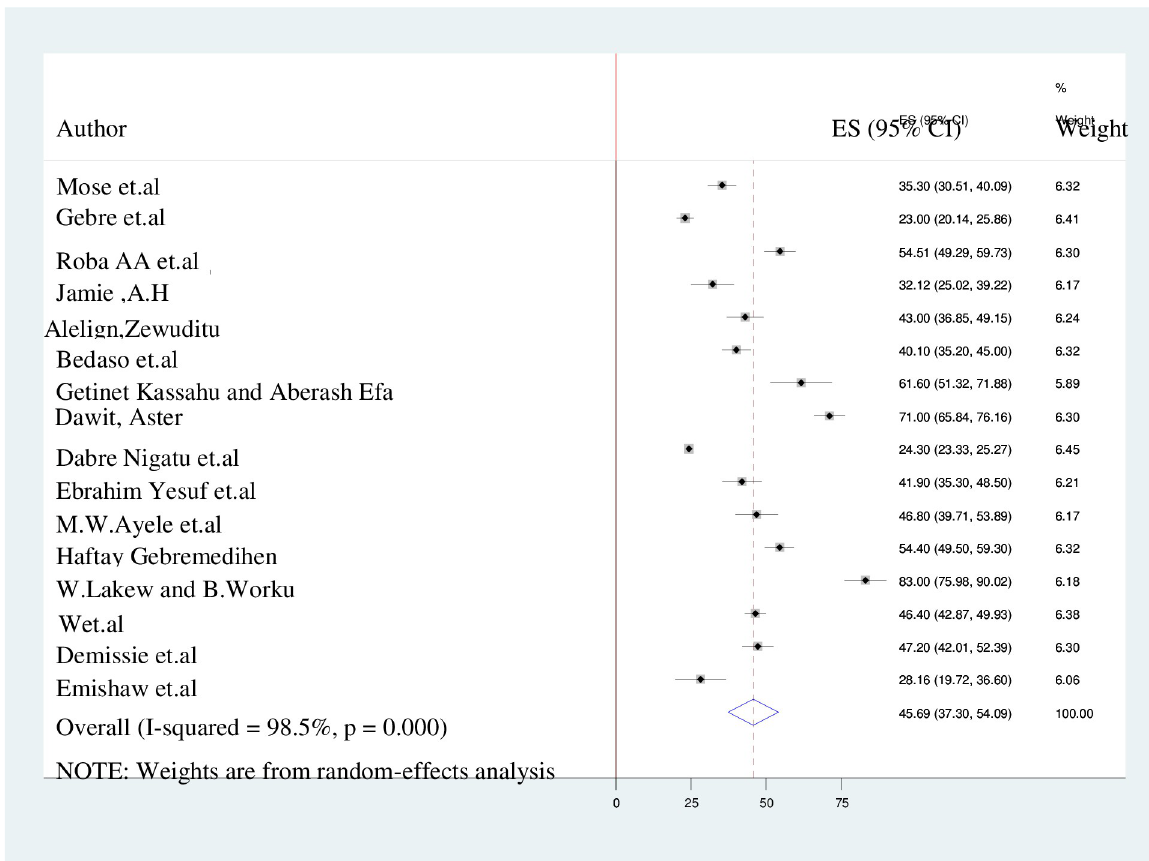
Fig 4. The forest plot of practice with the height of the diamond is the overall effect size (45.7%) while the width is the confidence interval at 95% (37.30%-54.09%). The y-axis shows the standard error of each study while the x-axis the estimate of effect size of the each study. The vertical line denotes the no effect. The square represents the effect size of each study and the line across the square is confidence interval of each study.